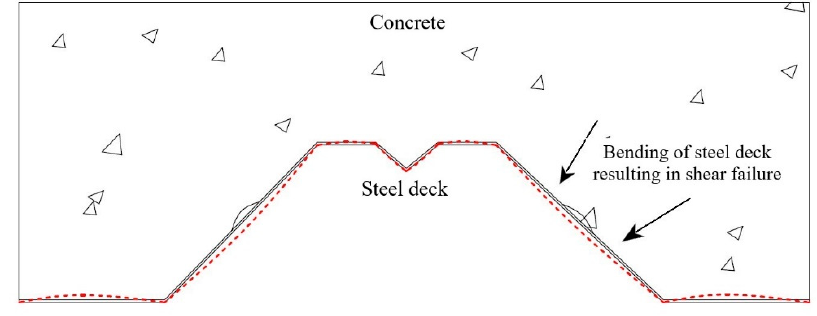
Figure 3. Failure mechanism of steel decks in composite stage.